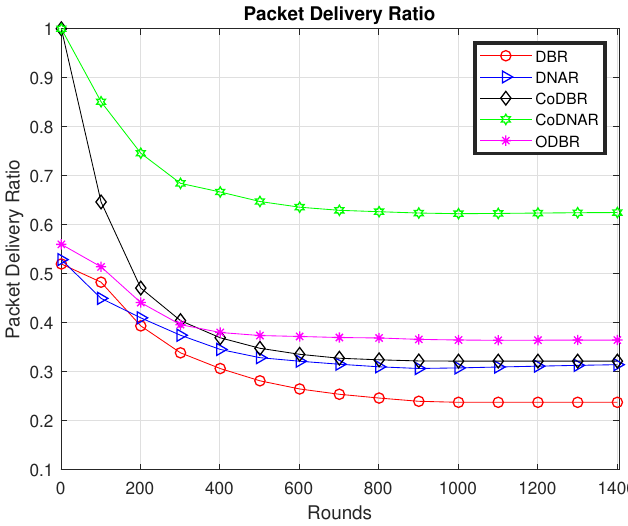
Figure 13. Total packets received at the sink surface